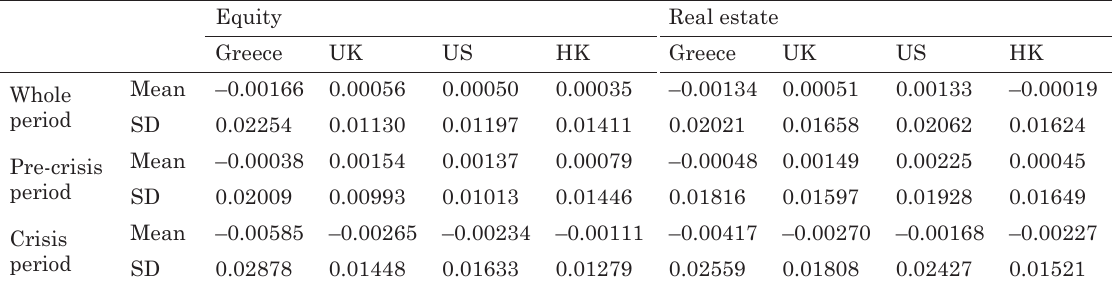
Table 2. The descriptive